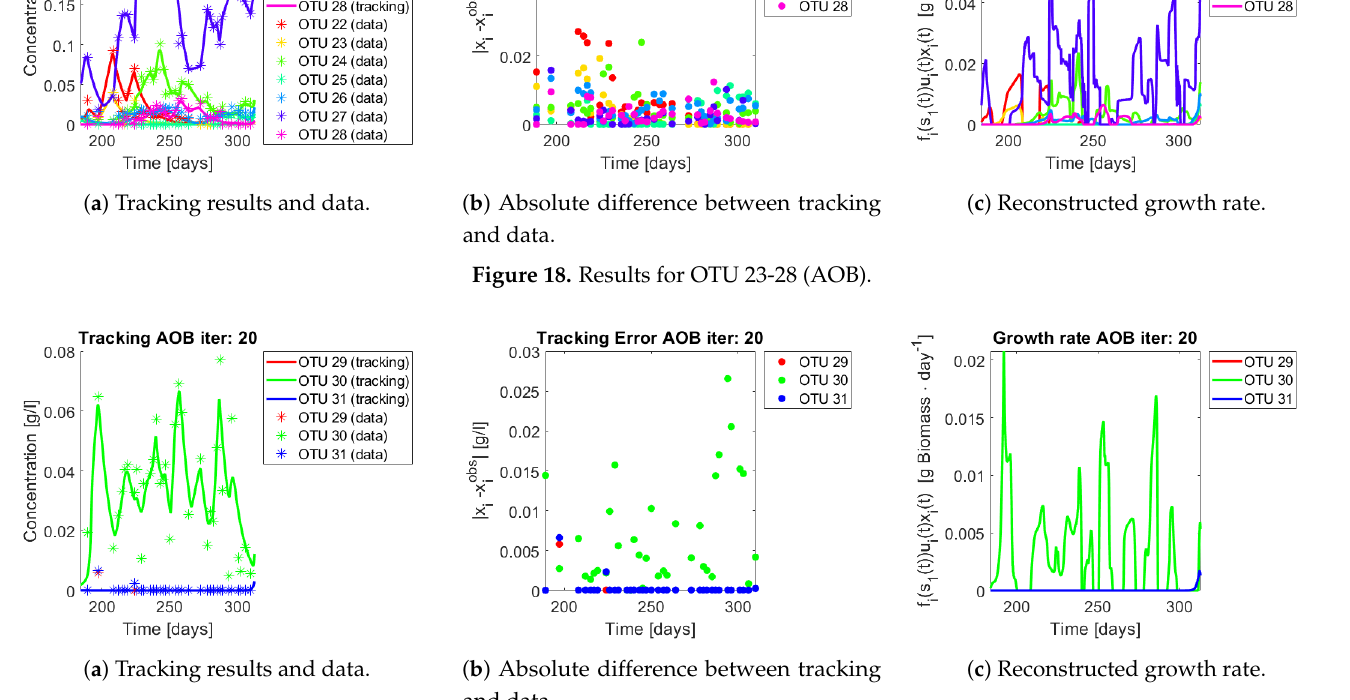
Figure 19. Results for OTU 29-31